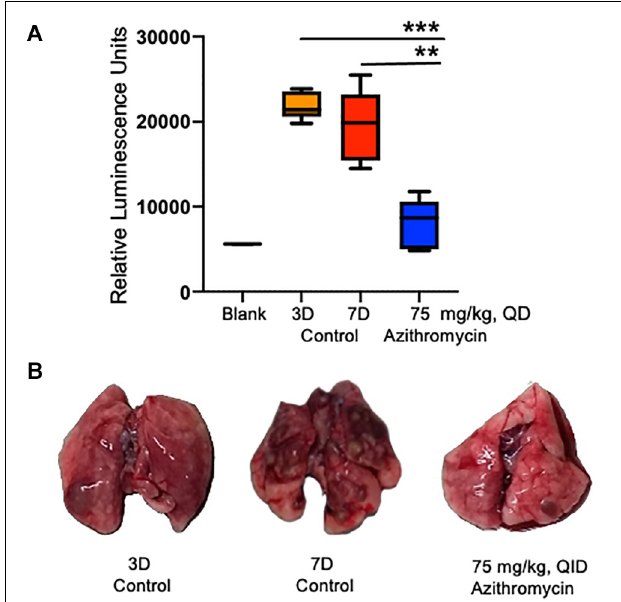
FIGURE 5 | Detection of QS molecule in the epithelial lining fluid (ELF) of infected rats. QS molecule was determined 3 days post-infection, when the treatment was started and at 7 days post-infection in the placebo control and azithromycin treated rats (A) . Representative lungs photos of 3D, 7D and azithromycin treated rats (B) . The asterisks indicates a significant difference compared with those of 7D control group (** P < 0.01, ***P <